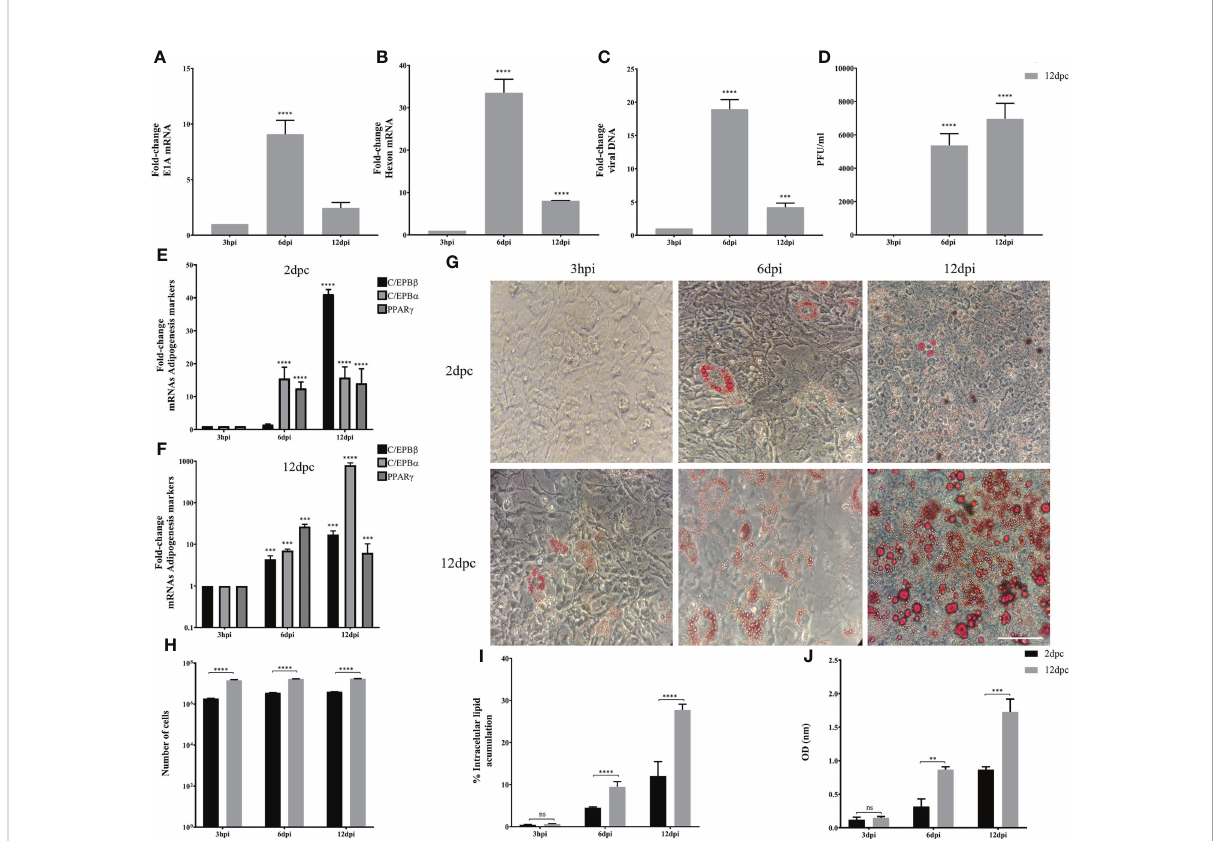
FIGURE 3 3T3-L1 cells at 12 dpc, but not at 2 dpc, are permissive for HAdV-D36 replication. 3T3-L1 cells, 2dpc or 12dpc, were infected with HAdV-D36 in the presence of MDI. Viral mRNA expression levels of E1A (A) , and Hexon (B) were measured by RT-qPCR. DNA was isolated and analyzed by qPCR (C) and viral progeny production was determined by plaque assay (D) . The expression levels of C/EBP b , C/EBP a and PPAR g was measured by RT-qPCR (E, F) . Intracellular lipid accumulation was observed by ORO staining and white fi eld microscopy (G) . Scale bar = 100 m m. Cell numbers were measured using a Neubauer chamber (H) . Change in the percentage of cells with lipid accumulation in the presence of MDI were counted using ORO staining and white fi eld microscopy (I) , the relative quantities of lipid accumulation were determined by elution of ORO staining, measured at 510 nm Optical Density (OD) (J) . Primers were designed to hybridize at exon-exon junctions to measure mature mRNA and to hybridize at sequences that correspond to intron-exon junctions to measure DNA. All values represent the mean of two independent experiments, measured in technical duplicates. Data are expressed as the mean and error bars represent standard deviations. Signi fi cant differences from each time-point relative to 3h (A – F) and between 2 and 12 dpc at each time-point (H-J) are indicated